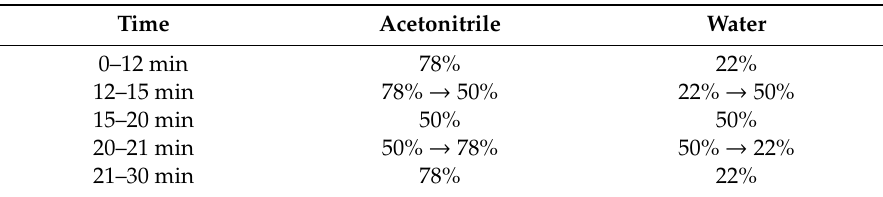
Table 3. HPLC gradient